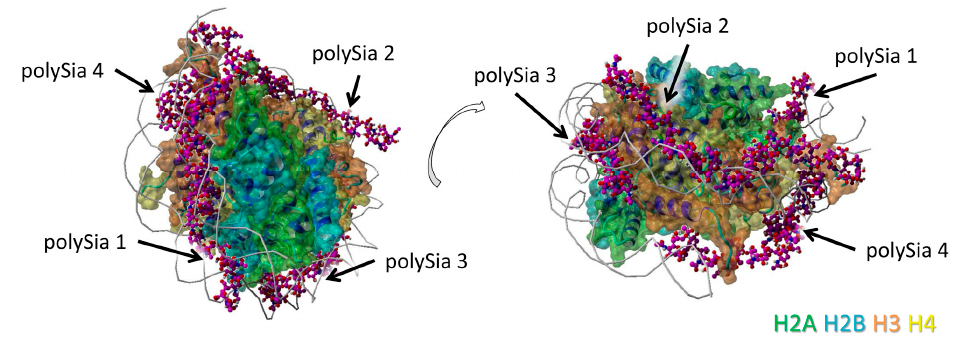
Figure 1. Model of interaction between polySia and histones. This model includes the histone-octamer